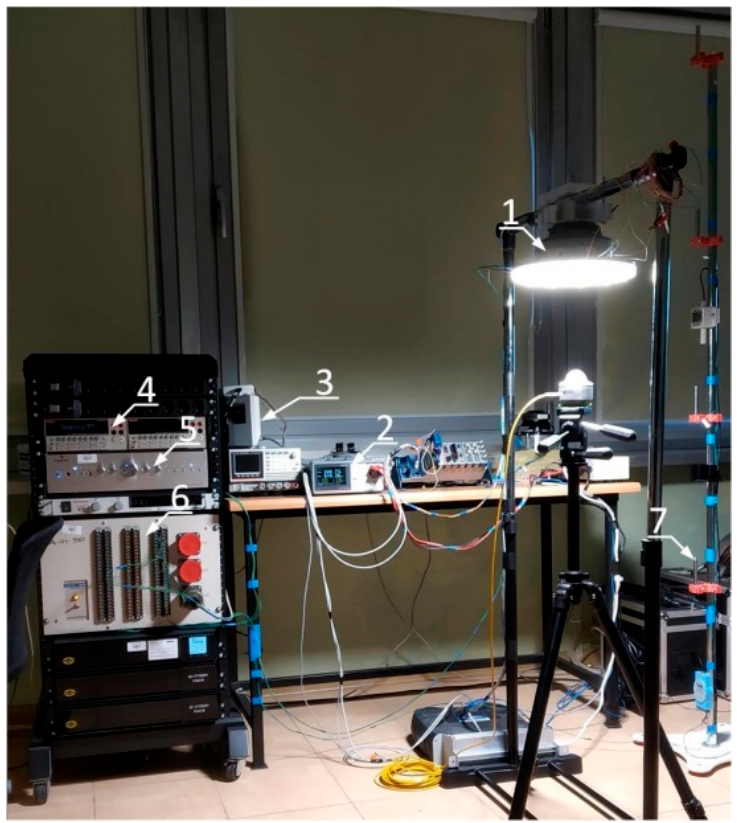
Figure 5. Experimental setup: 1—LED lamp, 2—power meter, 3—function generator, 4—multimeter, 5—acoustic amplifier, 6—automatic ice point reference, 7—stand with four thermocouples to measure the ambient temperature.